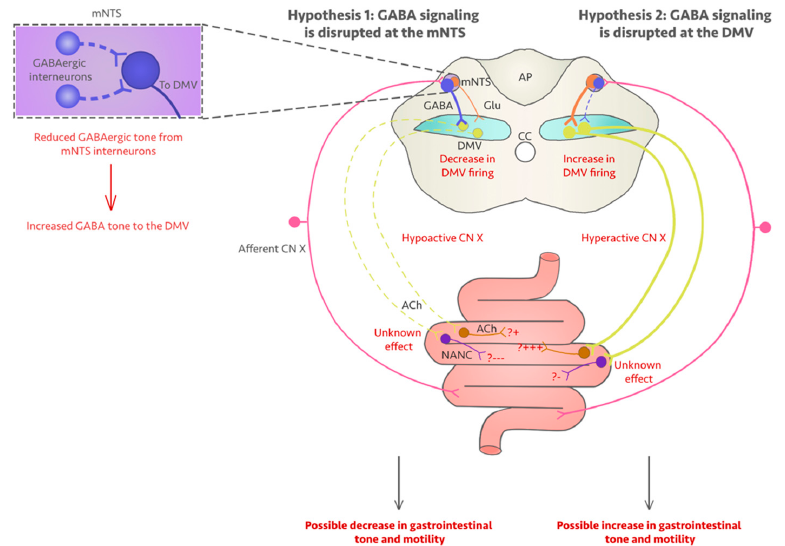
Figure 2. Schematic representation of our proposed pathophysiological mechanism of vagal dys- function following FQs administration. Left: If blockade of GABAA receptors occurs in the medial Nucleus of the Tractus Solitarius (mNTS), GABAergic interneurons at this level (blue neurons, dashed lines) would not be able to properly suppress GABAergic mNTS neurons (blue neuron) targeting the Dorsal Motor Nucleus of the Vagus (DMV). As a result, the GABAergic tone coming from the mNTS to the DMV would be increased, with unknown effects on the glutamatergic signaling from the mNTS (orange neuron). As such, we would expect DMV neurons (yellow, dashed lines) to be inhibited, causing an hypoactivation of the vagus nerve. In this scenario, we expect little changes in the activatory myenteric cholinergic neurons (gold), but a drastic overactivation of the inhibitory Non-Adrenergic Non-Cholinergic (NANC) pathway (purple), possibly leading to a de- crease in gastric tone and motility. Right: If blockade of GABAA receptors occurs in the DMV, with Fluoroquinolones simultaneously antagonizing GABAA receptors and reducing the Mg 2+ block on NMDA receptors, the fine balance between glutamate and GABA signaling from the NTS could potentially facilitate glutamatergic transmission, hence exciting a bigger population of pregangli- onic cholinergic neurons within the DMV. As a consequence, we could expect the cholinergic path- way in the myenteric plexus to be overactivated. Abbreviations: ACh, acetylcholine; AP, Area Postrema; CC, Central Canal; CN X, Cranial Nerve X; DMV, Dorsal Motor Nucleus of the Vagus; Glu, glutamate; NANC, Non Adrenergic Non Cholinergic; NTS, Nucleus of the Tractus Solitarius. Pharmacological administration of bicuculline in the DVC to decrease GABAergic signaling has been tested extensively in the laboratory [115,155]. Blockade of GABA sig- naling produces an expected increase in gastric tone and motility in a dose-dependent manner. On the other hand, bicuculline in the mNTS causes the opposite effect [147]. With FQs acting similarly to bicuculline [78,79,142], we can conclude that these drugs can in- deed induce motility issues; whether these issues will depend on increased vagal drive, as observed for example in gastrointestinal esophageal reflux disease (GERD; [103,156]) and diet-induced obesity [115], or by a decrease in vagal tone as observed for example in irritable bowel syndrome [157], Crohn’s disease, Necrotizing Enterocolitis [158] or func- tional gastrointestinal disorders [155] is yet to be determined. This picture becomes even more complicated when we consider that GABA is not the only neurotransmitter affected by FQs; as discussed earlier, NMDA receptors are modulated by FQs as well [81], possibly due to their ability to chelate Mg 2+ ions, hence disinhibiting these receptors [21,22,47,48].